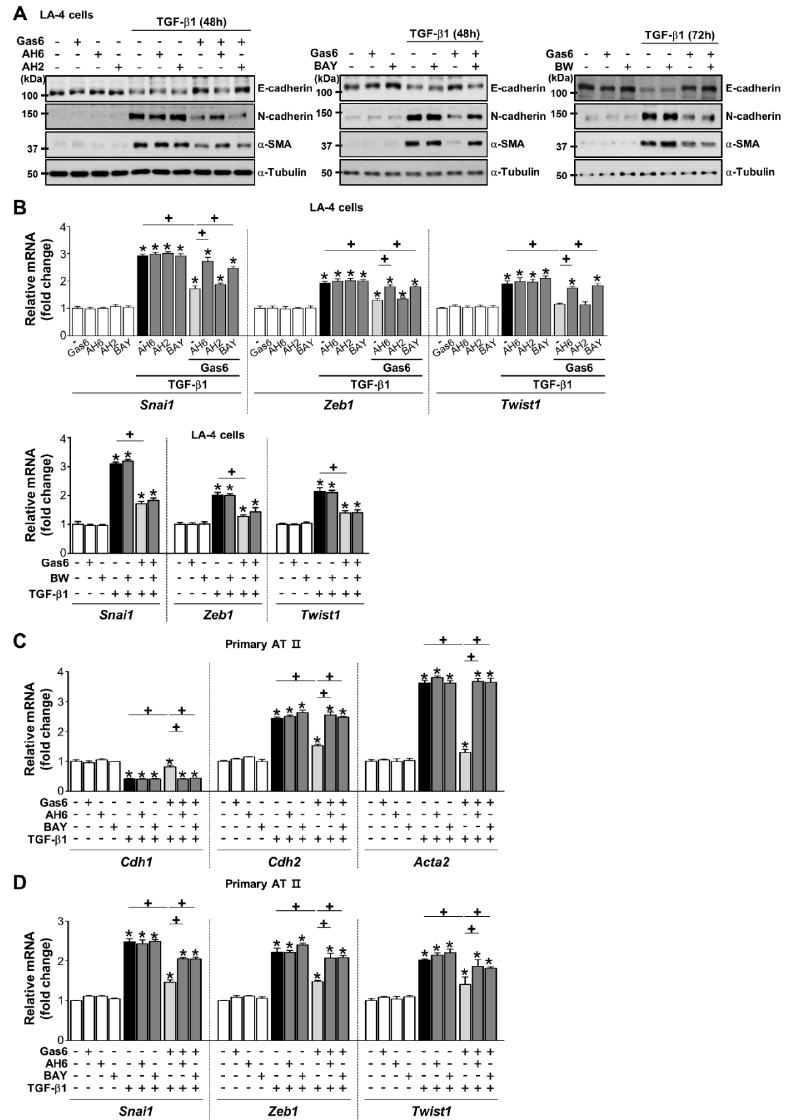
Figure 5. Prostaglandin (PG)E 2 and PGD 2 secretion inhibits growth arrest-specific protein 6 (Gas6)-induced epithelial-mesenchymal transition (EMT) via their receptors. ( A – D ) LA-4 and AT II epithelial cells (ECs) were stimulated with 400 ng / mL Gas6 for 20 h and then stimulated with 10 ng / mL TGF- β 1 for 48 or 72 h with or without antagonists of EP2 (AH-6809), EP4 (AH-23848), DP1 (BW-A868C), or DP2 (BAY-u3405), each at a dose of 10 µ M. ( A ) Representative immunoblots of total cell lysates were performed with anti-E-cadherin, -N-cadherin, or - α -SMA antibodies. ( B ) qPCR analysis of the mRNAs of EMT transcription factors in LA-4 ECs. ( C , D ) qPCR analysis of the mRNAs of EMT markers and EMT transcription factors in primary AT II ECs. Values represent the mean ± S.E. of three independent experiments. * P < 0.05 compared with control; + P < 0.05 as